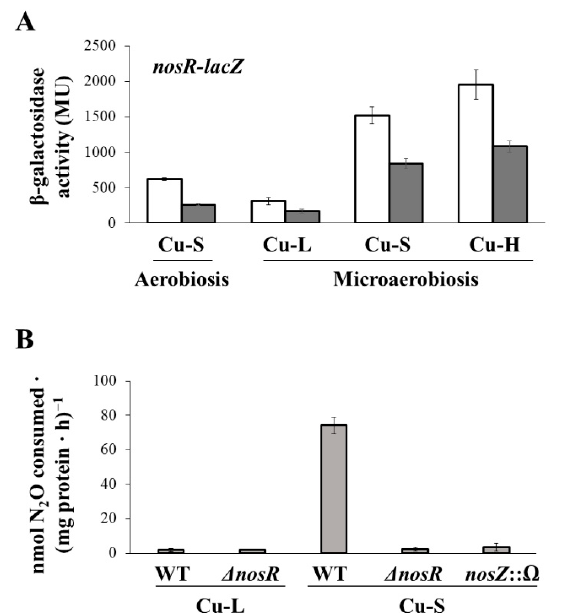
Figure 7. ( A ) β -galactosidase activity from the nosR-lacZ transcriptional fusion chromosomally integrated in B. diazoefficiens 110 spc 4 (white bars) and nosR mutant backgrounds (dark grey bars) grown aerobically in Cu-S or microaerobically in Cu-L, Cu-S and Cu-H BVMN media for 3 days. Data expressed as Miller Units (MU) are means with standard error bars from at least three independent cultures assayed in triplicate. ( B ) Nitrous oxide reductase activity of B. diazoefficiens 110 spc 4 (WT) and Δ nosR strains incubated in Cu-L and Cu-S BVMN media under microoxic conditions. The nosZ :: Ω mutant strain cultured in the Cu-S medium was used as negative control in the experiments. N 2 O was measured in the headspace of the cultures after 3 days of incubation. Data represent means with standard error bars from at least two independent cultures assayed in triplicate.